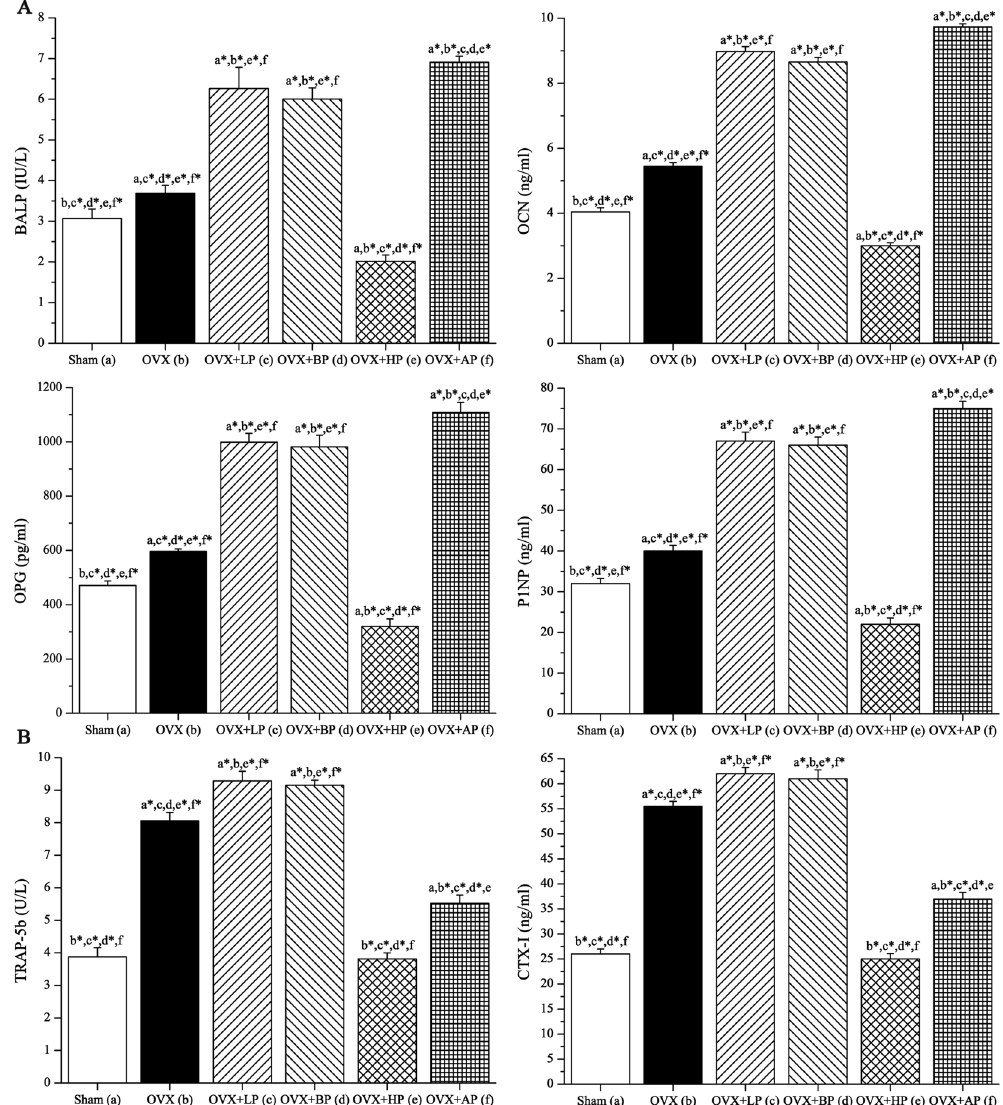
Figure 5. Effects of 8-week EMF exposure on serum biochemical indices (bone turnover markers) in OVX mice, including bone formation markers ( A ) and bone resorption markers ( B ). Values represent mean ± SD of 8/group. Letters a-f indicate differences between respective groups at P < 0.05 or * P < 0.01 (a versus Sham; b versus OVX; c versus OVX + LP; d versus OVX + BP; e versus OVX + HP; f versus OVX +